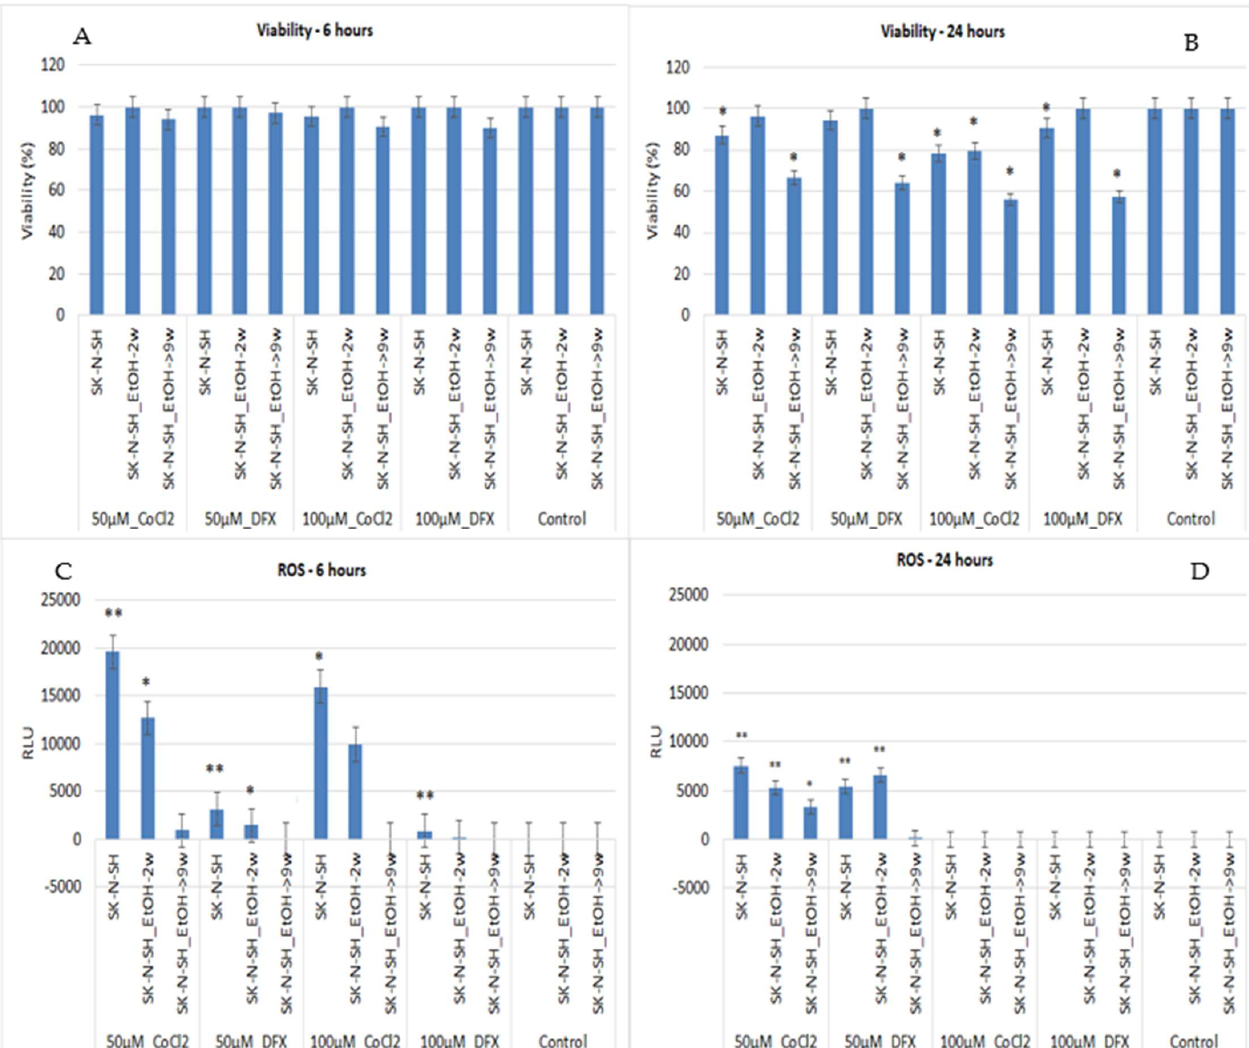
Figure 3. Quantification of cell viability and ROS release at 6 and 24 h in ethanol-exposed and non-exposed SK-N-SH cells treated with different concentrations of DFX and CoCl 2 . A p -value < 0.05 was considered statistically significant, * p < 0.05, ** p < 0.005.